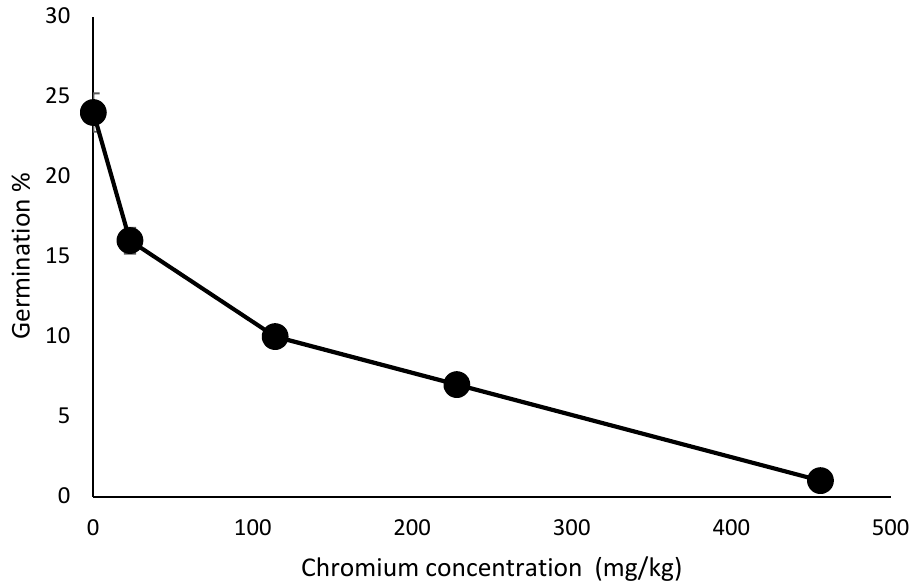
Figure 1. Germination percentage of plants in different concentrations of Cr(VI) along the y-axis (n = 3, SD). SD: standard deviation.